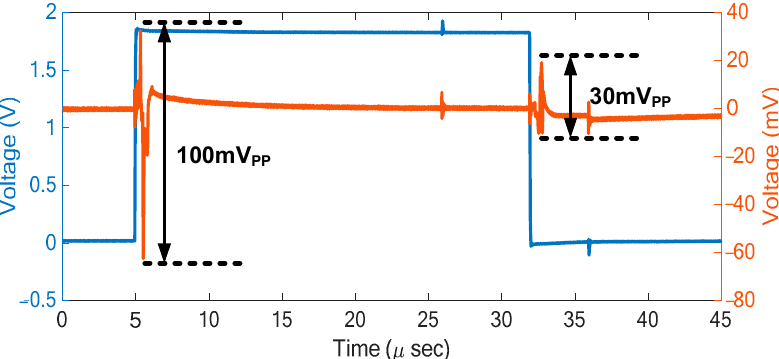
Figure 9. Measured waveforms of the RX phase (blue) and the switching transient observed on the element X [6, 41] (orange). element X [6, 41]